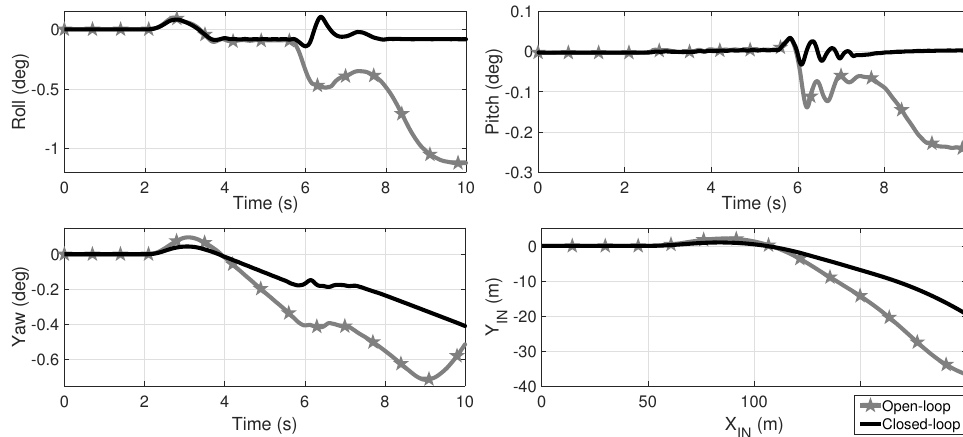
Figure 11. Comparative of the roll, pitch and yaw angles as well as the TWV displacement for open (black plots) and closed-loop (gray-star marked plots), and a friction coefficient µ = 0.85 for the maneuver of Figure 2a augmented by 300%. At the second 5.6, a speed bump is simulated by an exogenous road step (Figure 2b) in the front wheel and 0.1 seconds later in the rear right wheel. In open-loop, the vehicle suffers a rollover from second 6 as the roll angle indicates and in closed-loop the rollover is avoided; since the three wheels lose ground contact at second 5.8 oscillations are expected at TWV landing. In the Supplementary Material Section, a link is provided to video animations.